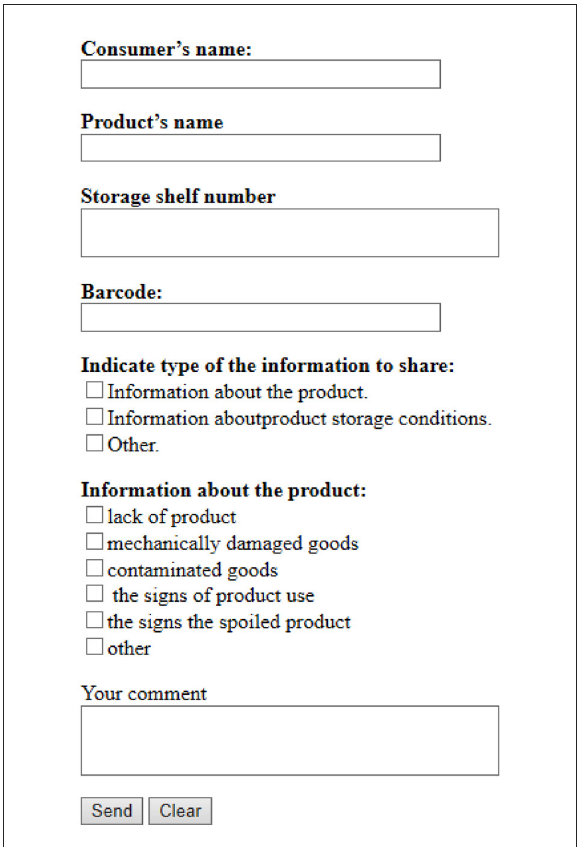
FIGURE4 General view of the web form to be filled out by consumers. Source: Authors’ depiction.